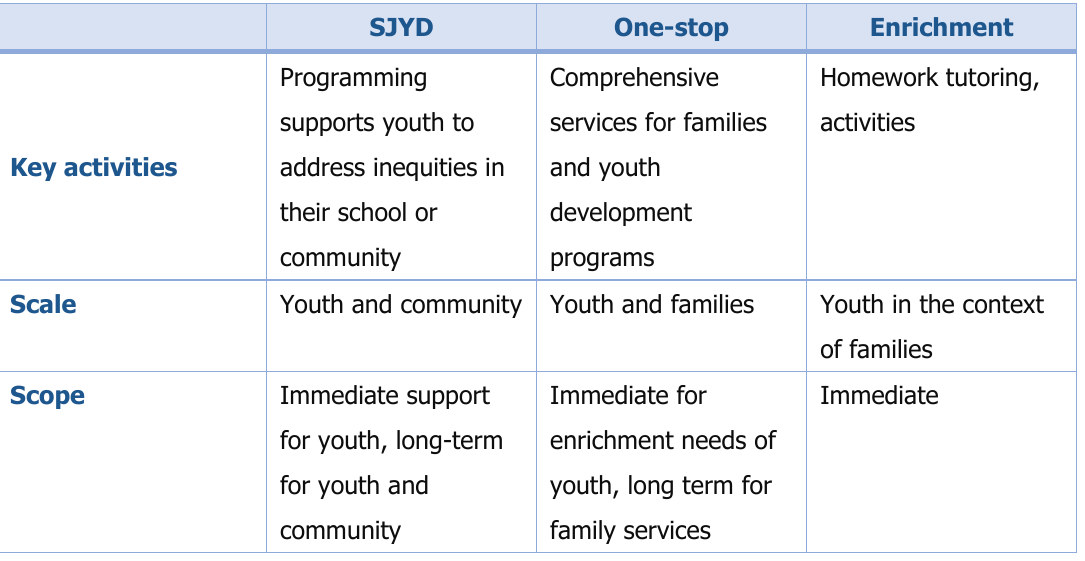
Table 4. Variations in Discourse, Scale, and Scope of Organization Types SJYD One-stop